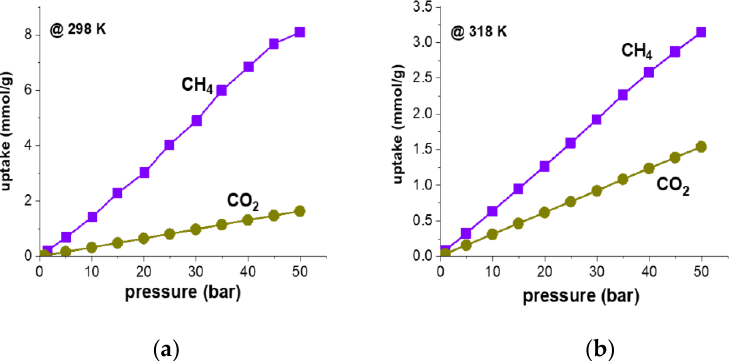
Figure 6. Plots of the CO 2 (violet squares) and CH 4 gas (green cycles) adsorption behavior of QUF- 001and the uptake of these two gases as a function of the pressure, at two different temperatures of 298 K ( a ) and 318 K ( b ).